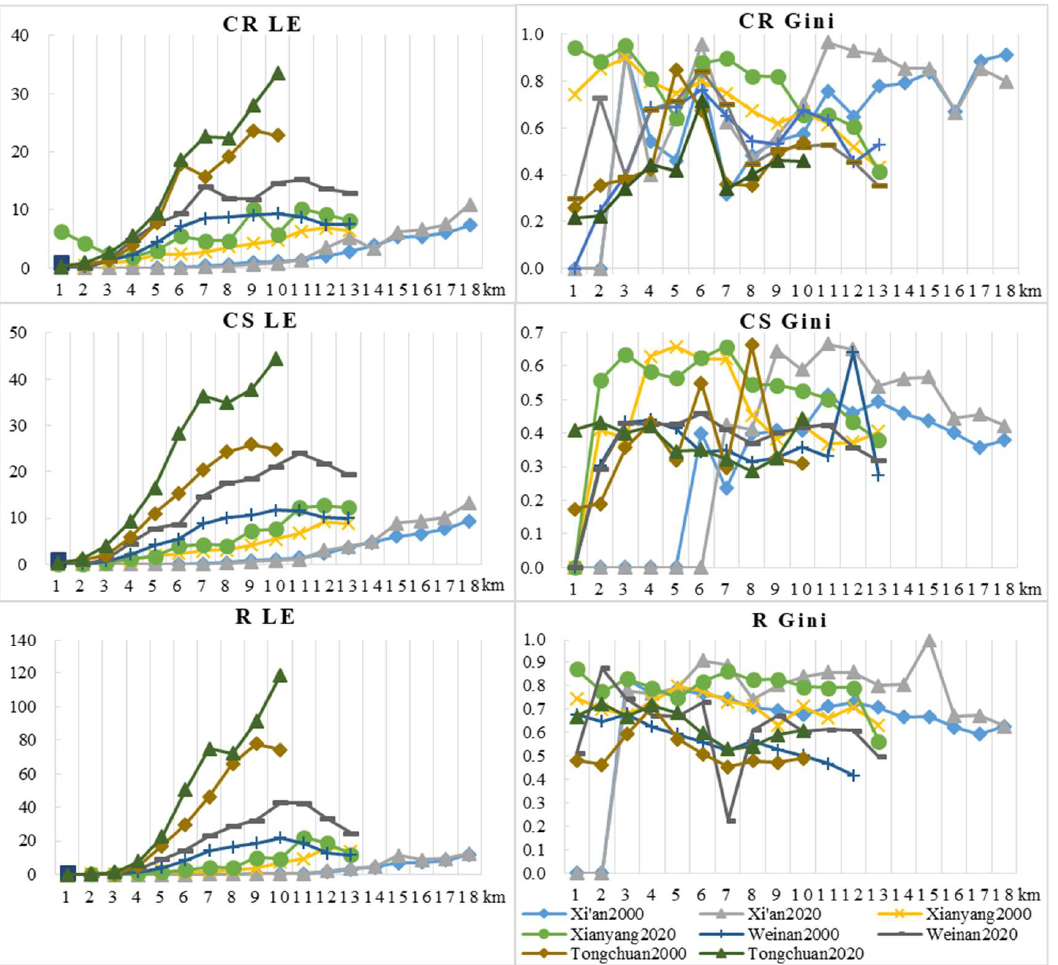
Figure 9. The spatial variation in the location entropy of climate regulation (CR LE), carbon sequestration (CS LE), and recreation (R LE) in differently sized cities in 2000 and 2020 along urban–rural gradients in the XMA; the spatial variation in Gini coefficient of climate regulation (CR Gini), carbon sequestration (CS Gini), and recreation (R Gini) in differently sized cities in 2000 and 2020 along urban–rural gradients in the XMA.